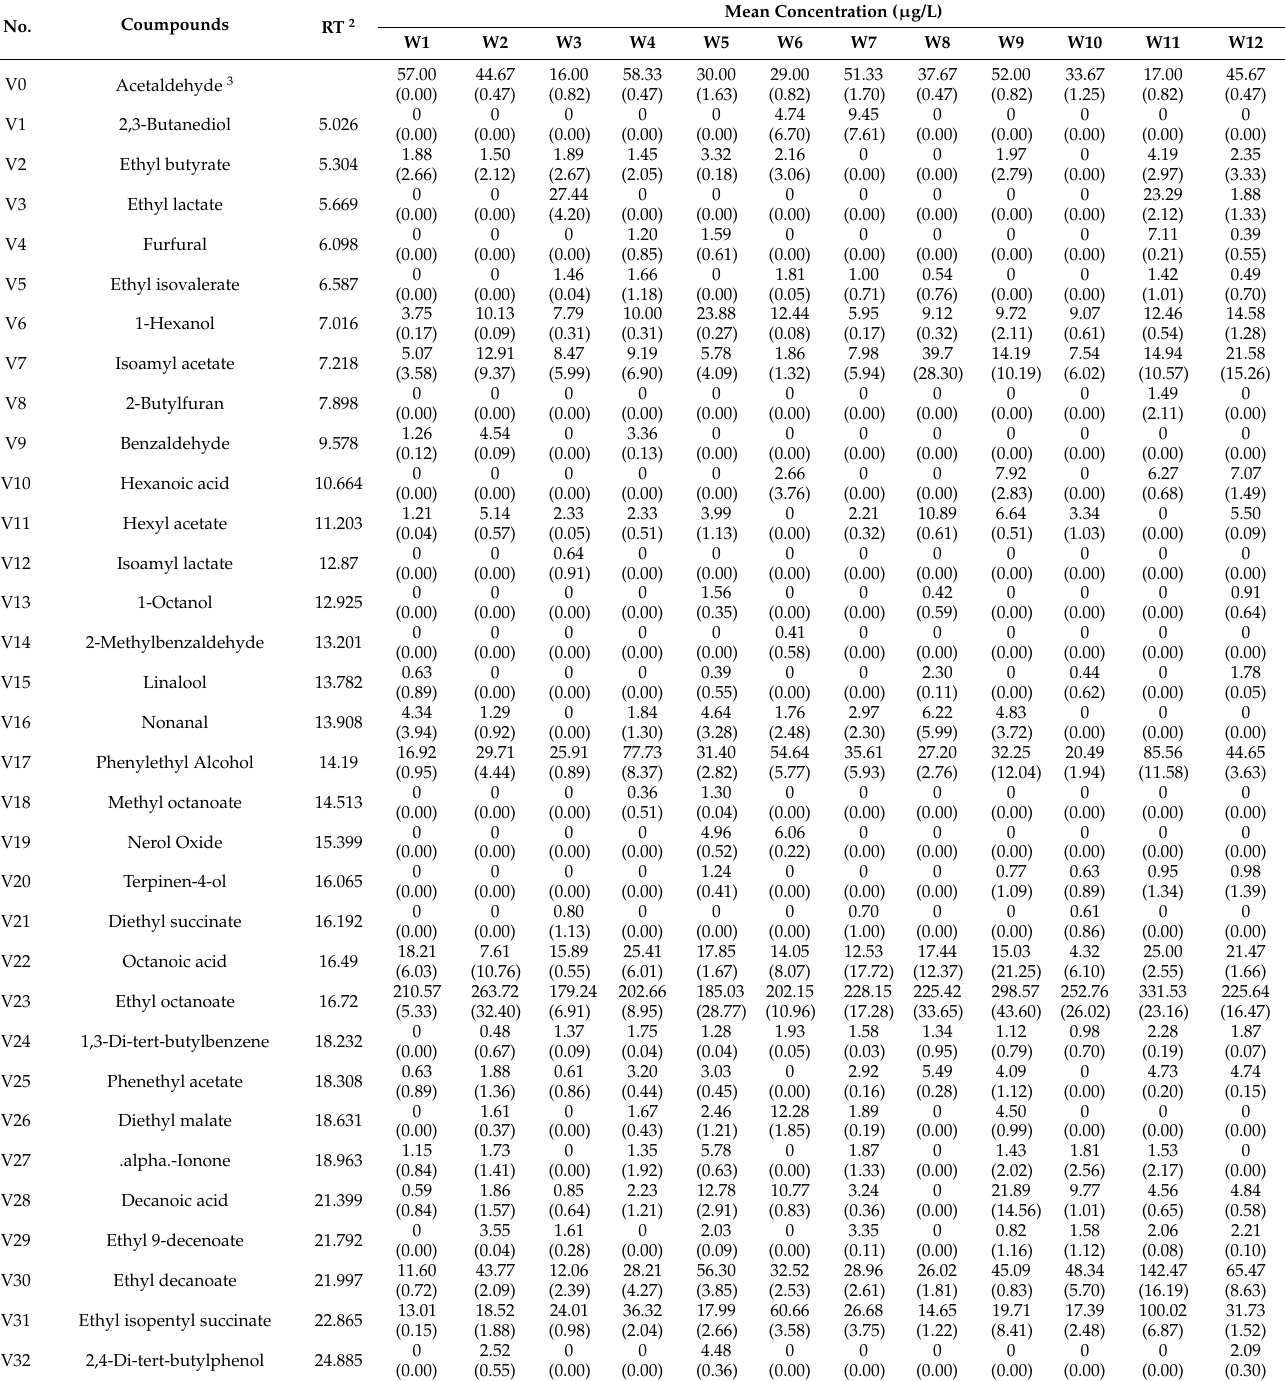
Table 4. Concentration of volatile compounds in the white wine samples ( µ g/L) 1